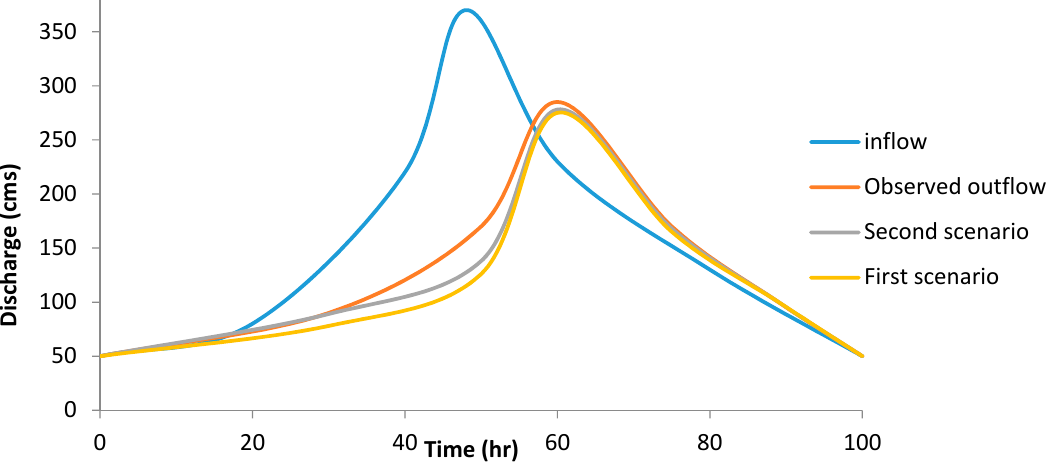
Figure 5. The first and second scenario for calibration of model.